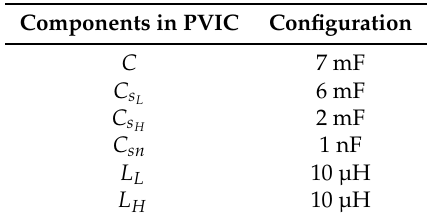
Table 3. Parameters of the electronic components in PVIC (see Figure 4).